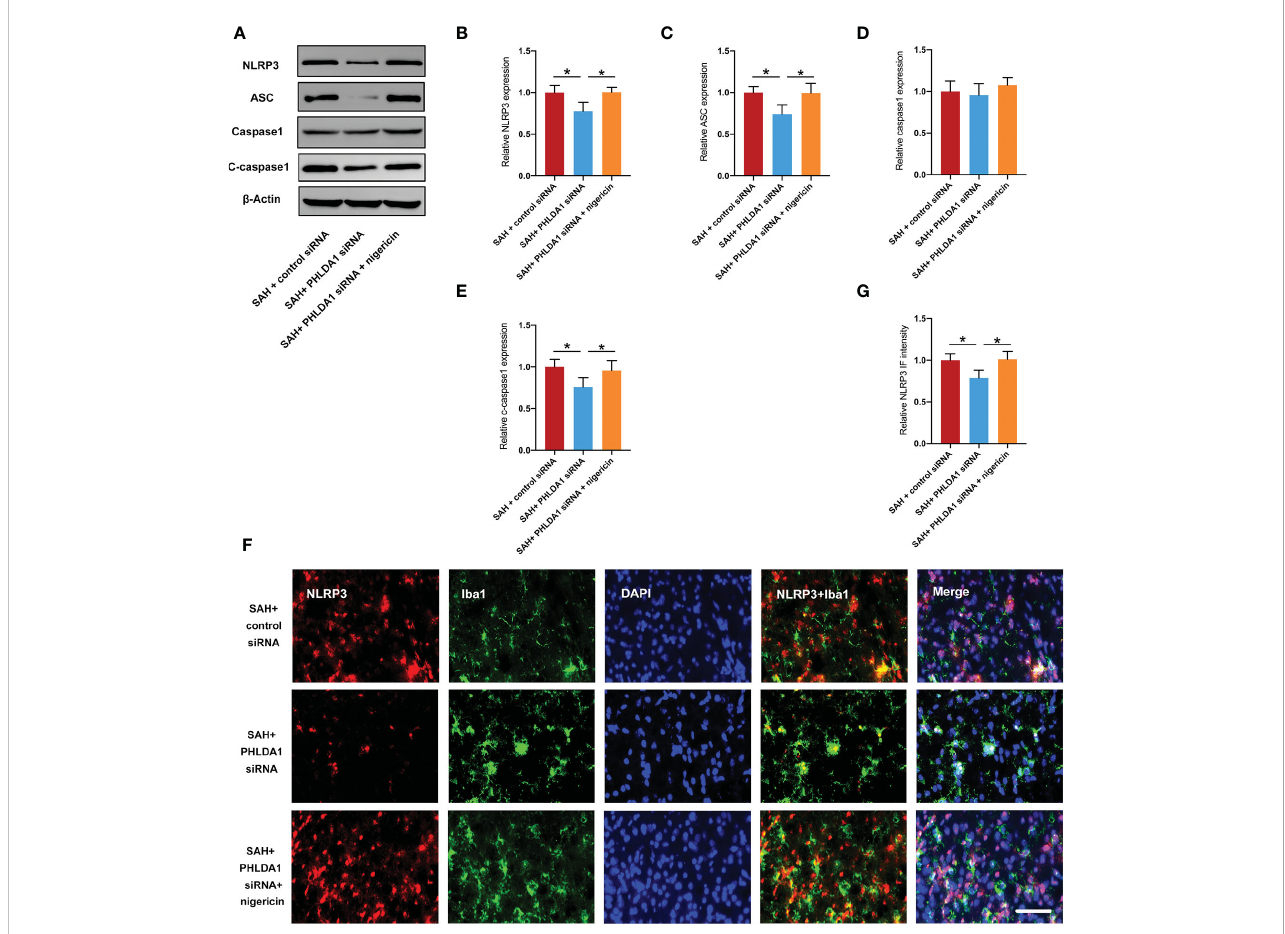
FIGURE 6 Nigericin administration counteracted the effects of PHLDA1 de fi ciency on NLRP3 in fl ammasome. (A) Representative western blots for NLRP3, ASC, caspase1, and cleaved caspasse1 expressions after SAH. Western blot analysis of NLRP3 (B) , ASC (C) , Caspase1 (D) , and Cleaved caspasse1 (E) expressions after SAH (n = 6 per group). (F) Representative immuno fl uorescence images of NLRP3 co-localized with Iba1 in temporal cortex. Quanti fi cation of NLRP3 (G) immunoactivity in microglia (n = 6 per group). * P < 0.05. Scale bar=50 m m. Data are expressed as mean ±